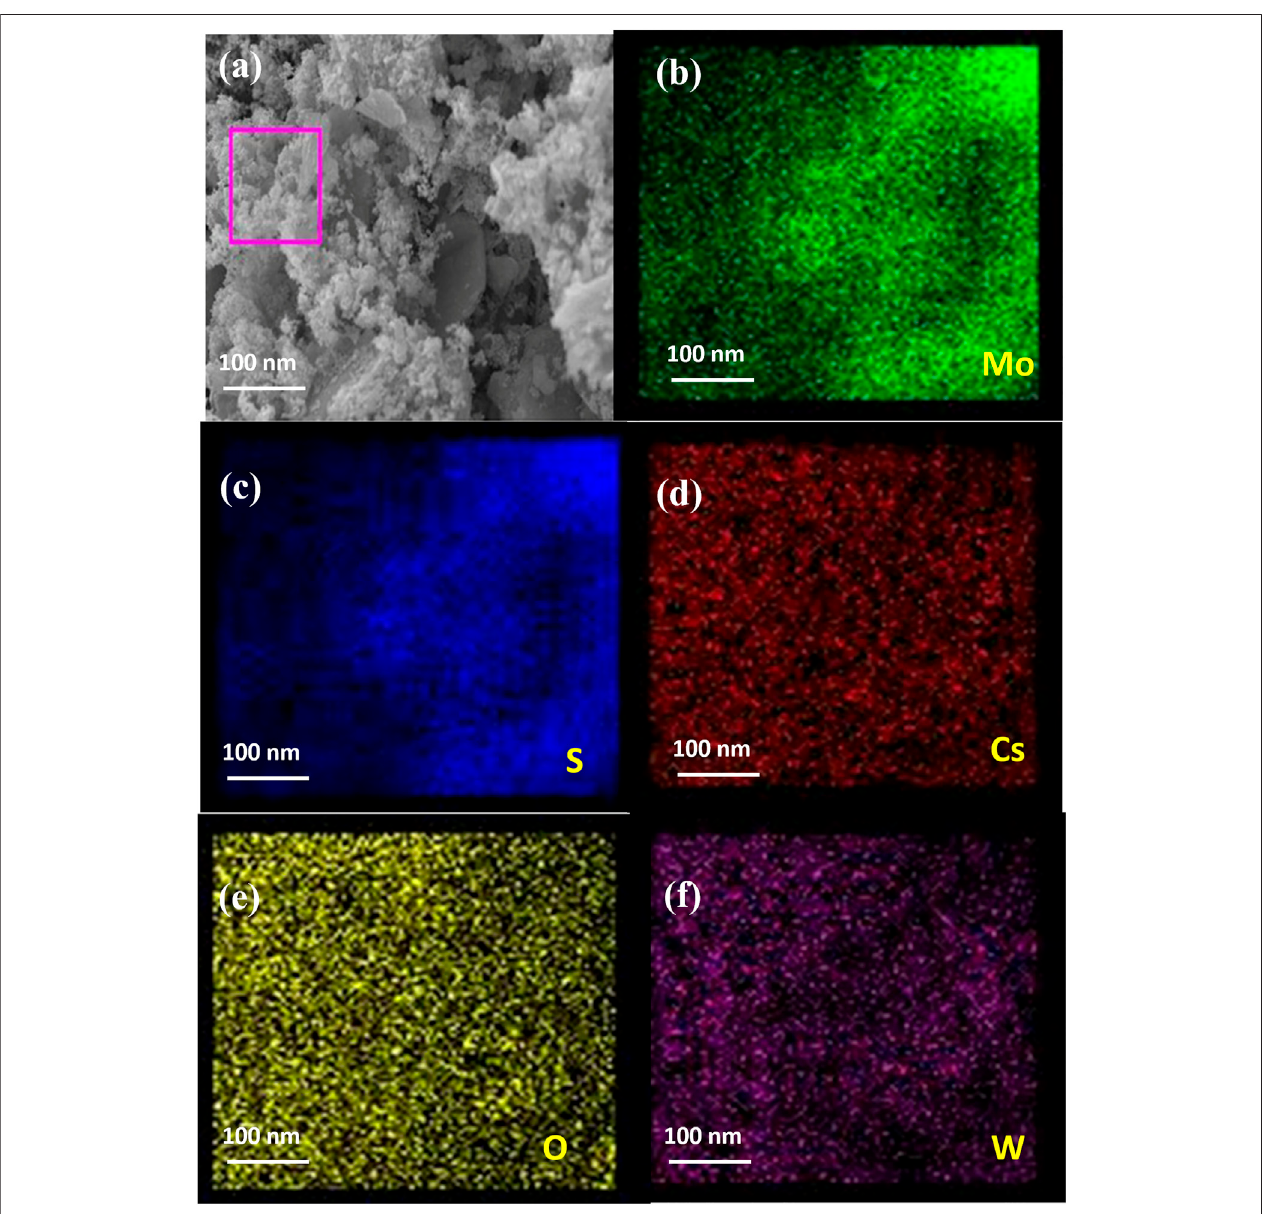
FIGURE 3 | (A) FESEM image and elemental mapping of (B) Mo, (C) S, (D) Cs, (E) O, and (F) W of 15% Cs x WO 3 /MoS 2 nanocomposite.